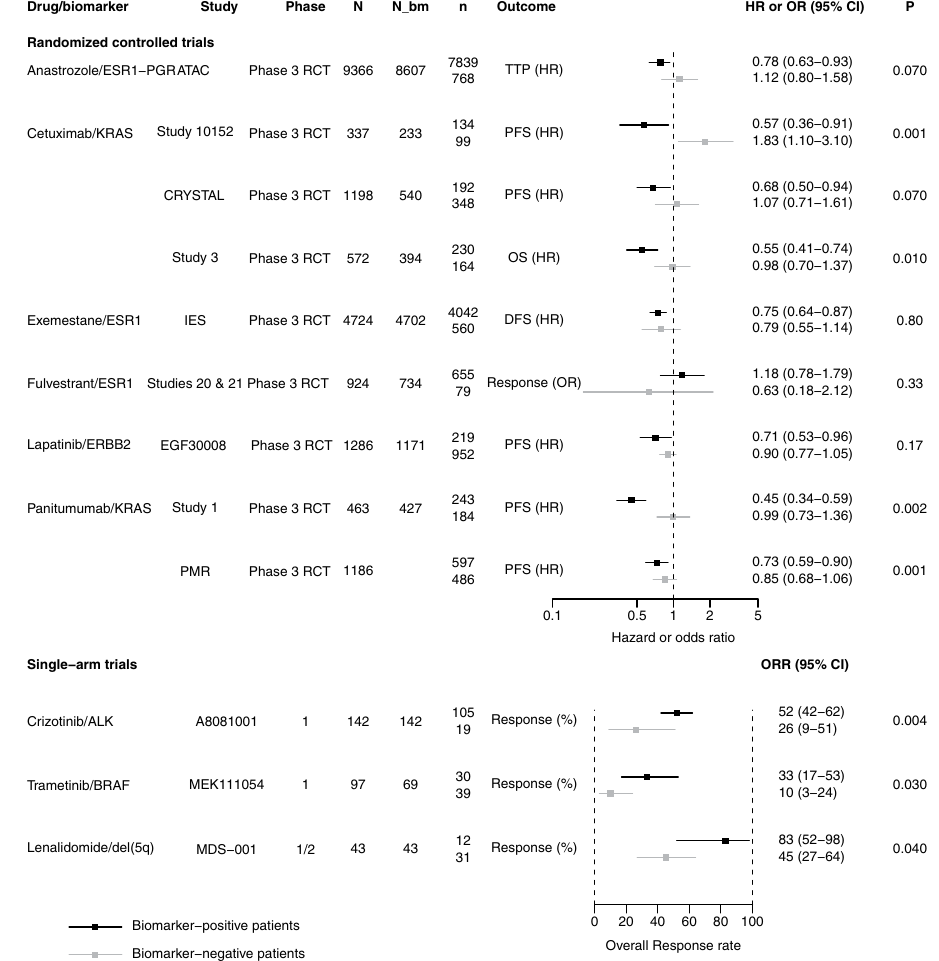
Figure 3. Characteristics of evidence supporting the clinical utility of pharmacogenomic biomarkers and treatment effect for 9 approvals of oncology drugs with at least one non-enriched clinical trial. Treatment effects are represented for biomarker-positive patients and biomarker-negative patients. N represents the total number of patients enrolled in the trial, N_bm the number of patients with a known biomarker status and n the number of patients in each biomarker-based subgroup. For randomized controlled trials, P is the p-value of the treatment-by-biomarker interaction. For single-arm trial, P is the p-value of the test comparing outcomes in biomarker-positive and biomarker-negative patients. Regarding fulvestrant/ESR1,when the superiority objectives were not met, the two pivotal trials were retrospectively assessed for non-inferiority with a 10% margin for overall response rate. Regarding Lapatinib/ERBB2, this approval is for the following indication: “in combination with letrozole for the treatment of postmenopausal women with HR + Metastatic breast cancer expressing HER2 receptor for whom hormonal therapy is indicated ”. Regarding Crizotinib/ALK, a cohort of ALK-negative patients was added to study B (A8081001), which had enrolled 119 ALK-positive patients (105 evaluable by an independent committee